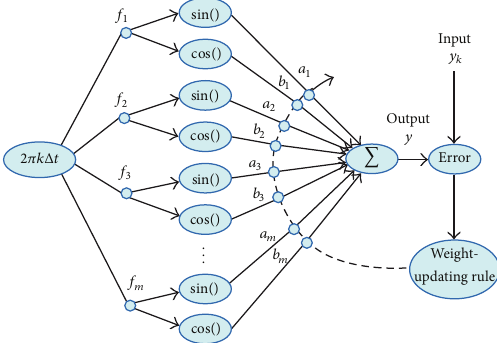
Figure 2: ADALINE block structure for frequency